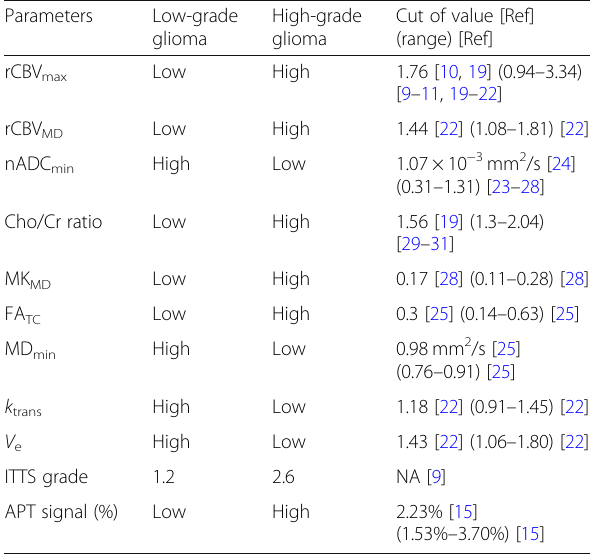
Table 1 Radiomic data for differential diagnosis of low-grade vs high-grade